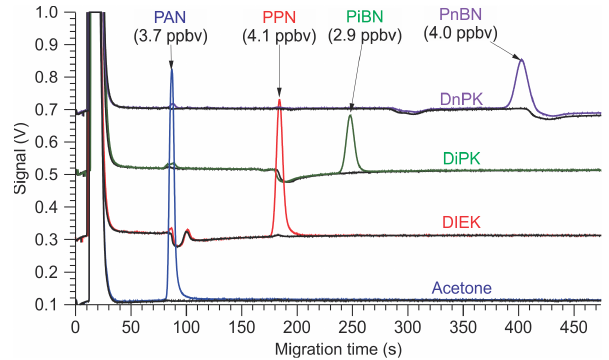
Figure 2. Sample chromatograms of PAN (blue trace), PPN (red trace), PiBN (green trace), and PnBN (purple trace) generated using the UV-LED photochemical source, 4.1ppbv of NO, and acetone, DIEK, DIPK, and DNPK, respectively. The black traces show the respective chromatograms before the UV-LEDs were switched on. The chromatograms were vertically offset for